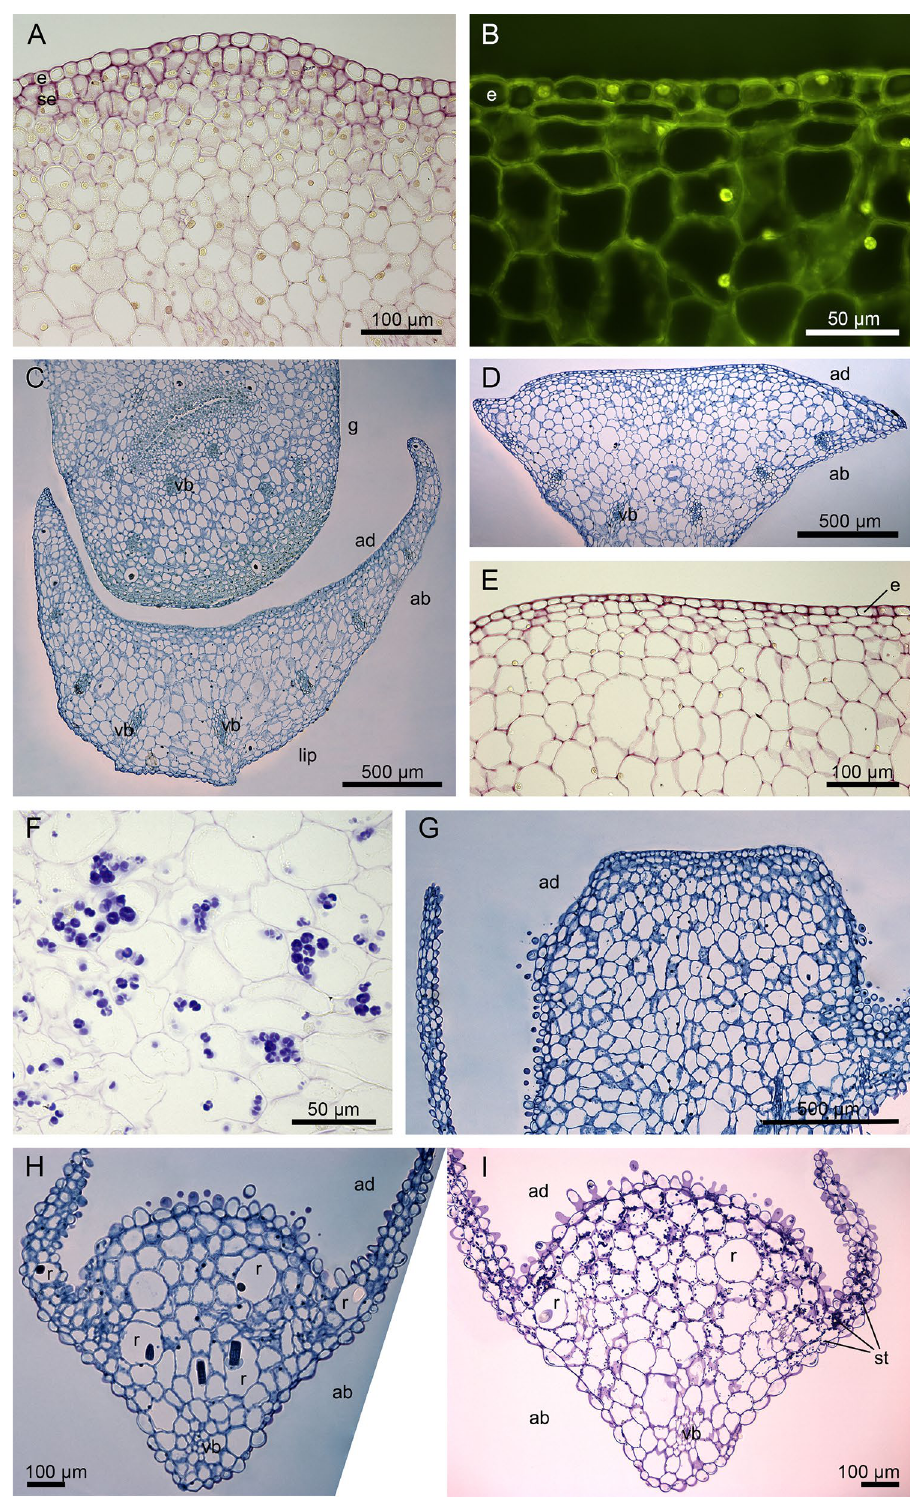
Figure 5. Histochemical tests of lip and the swollen mound of gynostemium: ( A ) The transverse section of the swollen mound with no detection of pectic acids/mucilage (Ruthenium Red); ( B ) The middle part of the lip with an unruptured cuticle on epidermal cells (Auramine O); ( C , D ) The small cells of epidermis and subepidermis with dense cytoplasm of gynostemium, but rather not active lip cells (TBO); ( E ) No detection of pectic acids/mucilage of the middle part of the lip (Ruthenium Red); ( F ) Few starch grains in ground parenchyma; ( G ) The part of the lip before the apex with papillate margins, noticeable slight outline of secretory activity (TBO). ( H , I ) The papillate apex with many idioblasts cells with raphide crystals (TBO) and starch grains (PAS). ab —abaxial (outer) side; ad —adaxial (inner) side; e —epidermis; g— gynostemium; r — idioblast with raphide crystals; se —subepidermis; st —starch grains; vb —vascular